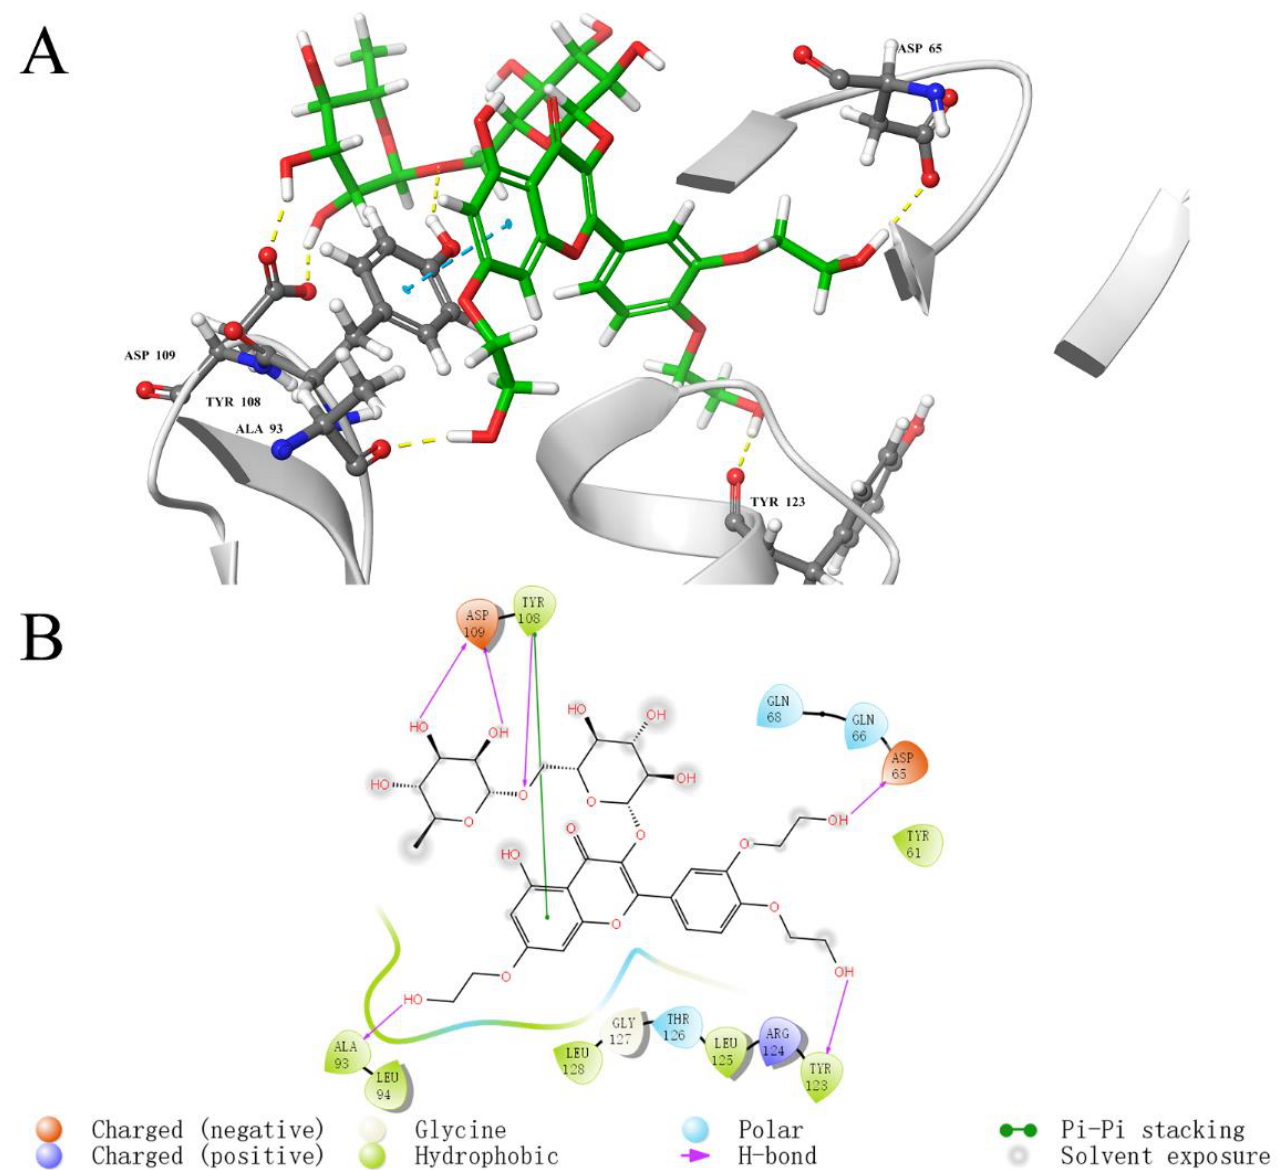
Figure 7. Molecular docking diagram of the interaction between troxerutin and LolB. ( A ): Detailed view of the LolB–troxerutin interaction sites. Amino acid residues involved in binding are shown in stick representation. H bonds are shown as yellow dashed lines and pi–pi stacking interactions are shown as cyan dashed lines. Troxerutin is labeled in green. ( B ): 2D diagram of interaction.